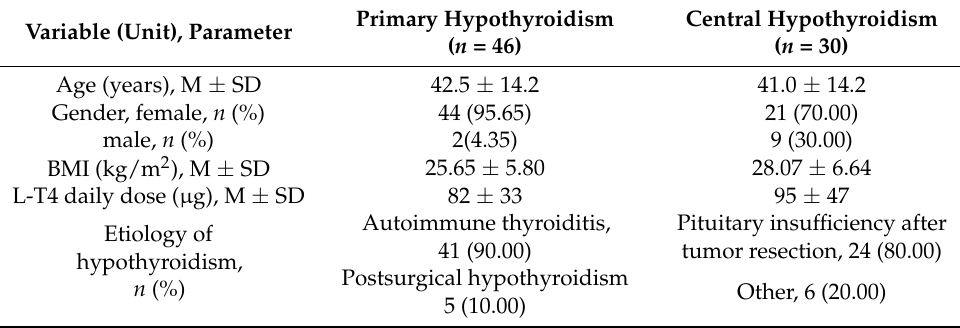
Table 1. Clinical characteristics of patients with primary and central hypothyroidism.